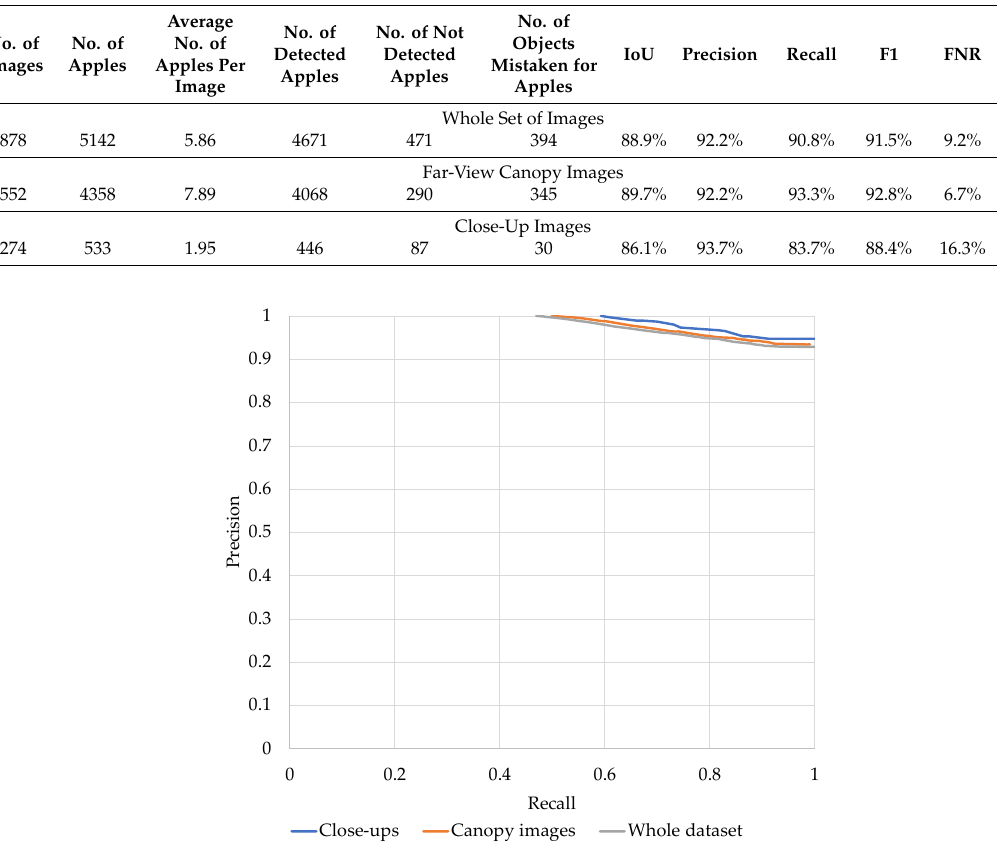
Table 2. Apple detection quality metrics.